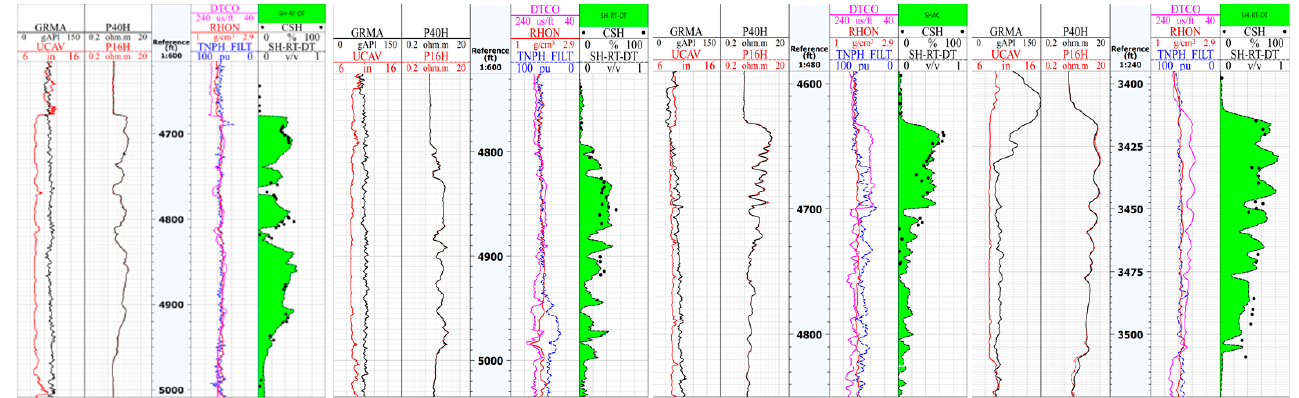
Figure 10. Gas hydrate saturation by using resistivity DT logging in W1, W2, W3, and W4.